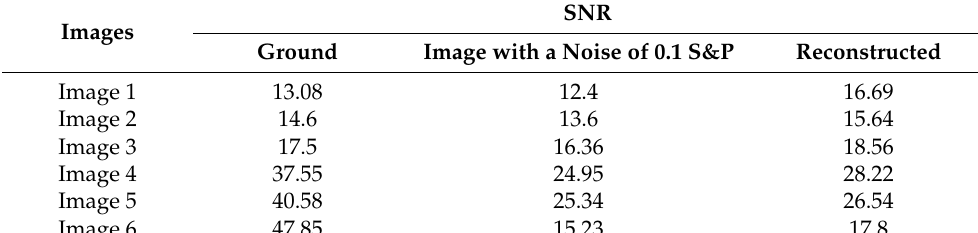
Table 3. Comparison of SNR of Images.